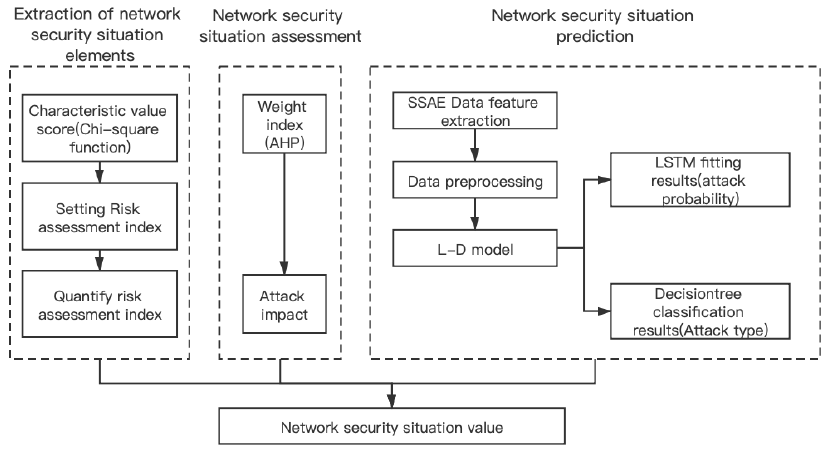
Figure 2. The design of the L-D network situation awareness